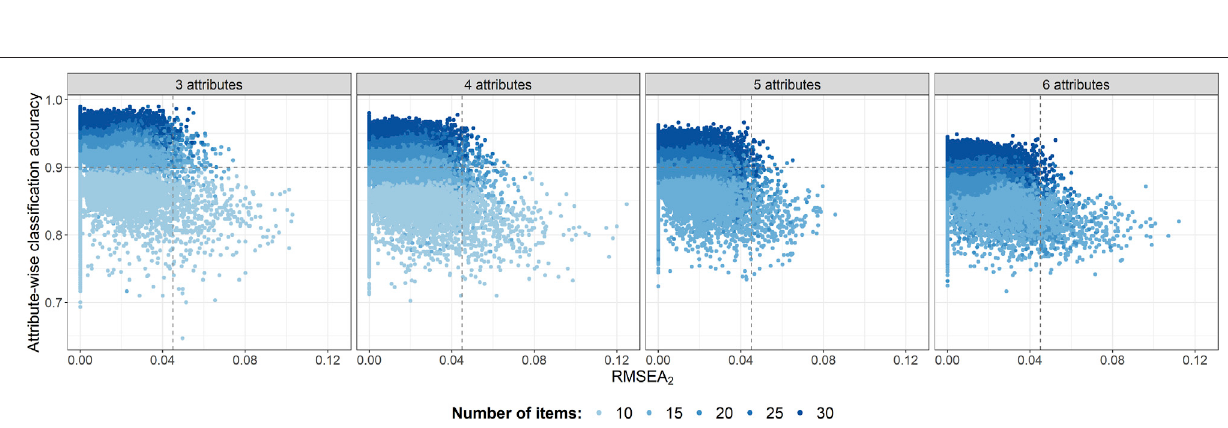
FIGURE3| Scatterplotofmarginal classi fi cation accuracyagainst RMSEA 2 in conditions withconsistentgeneratingand estimated models. Horizontal and vertical dashed lines indicate accuracy of 0.9 and RMSEA 2 of 0.045.